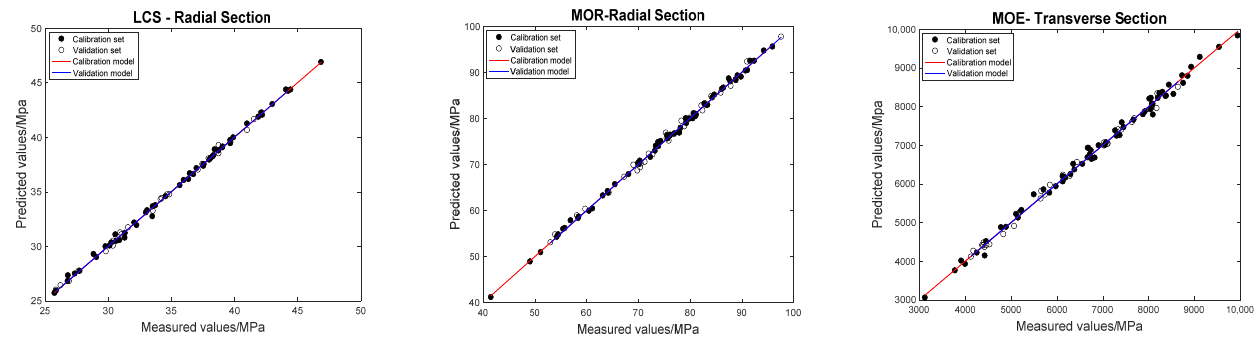
Figure 9. The SiPLS ‐ CARS ‐ PLSR predicting model for Larix gmelinii wood mechanical properties. Figure 9. The SiPLS-CARS-PLSR predicting model for Larix gmelinii wood mechanical